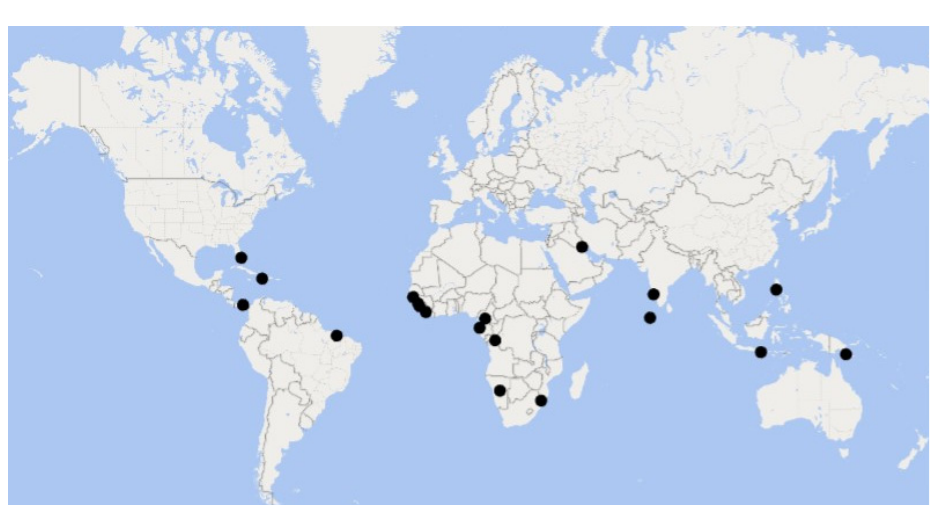
Figure 16. Major cities where CDD and PDPI are high